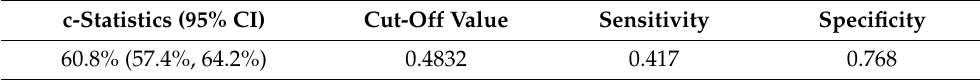
Table 4. Explanatory power of the model to determine TBI in elderly MVOs.